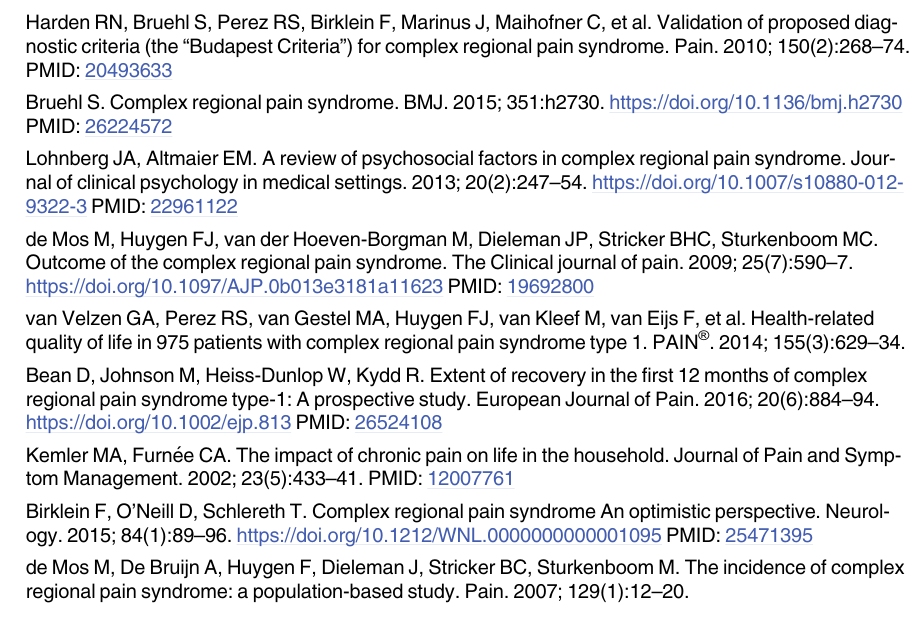
S1 Table. Data required for the analyses presented in this paper in an xlsx